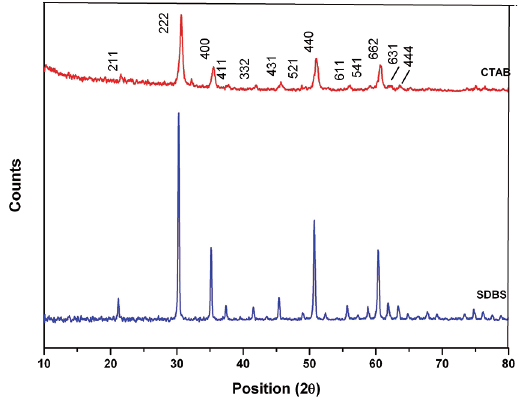
O samples capped with (a) CTAB 2 3